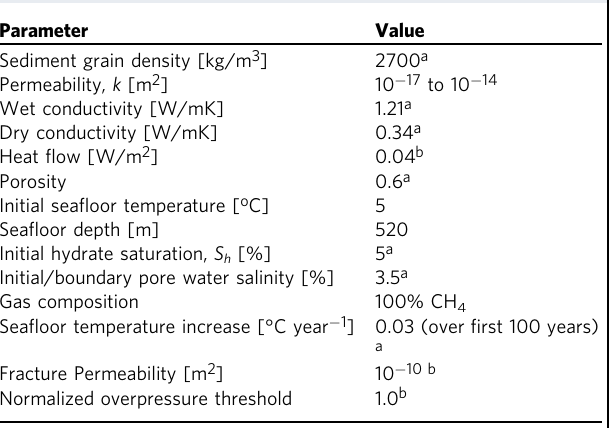
Table 2 Physical Properties and T + H-GeoMech Simulation